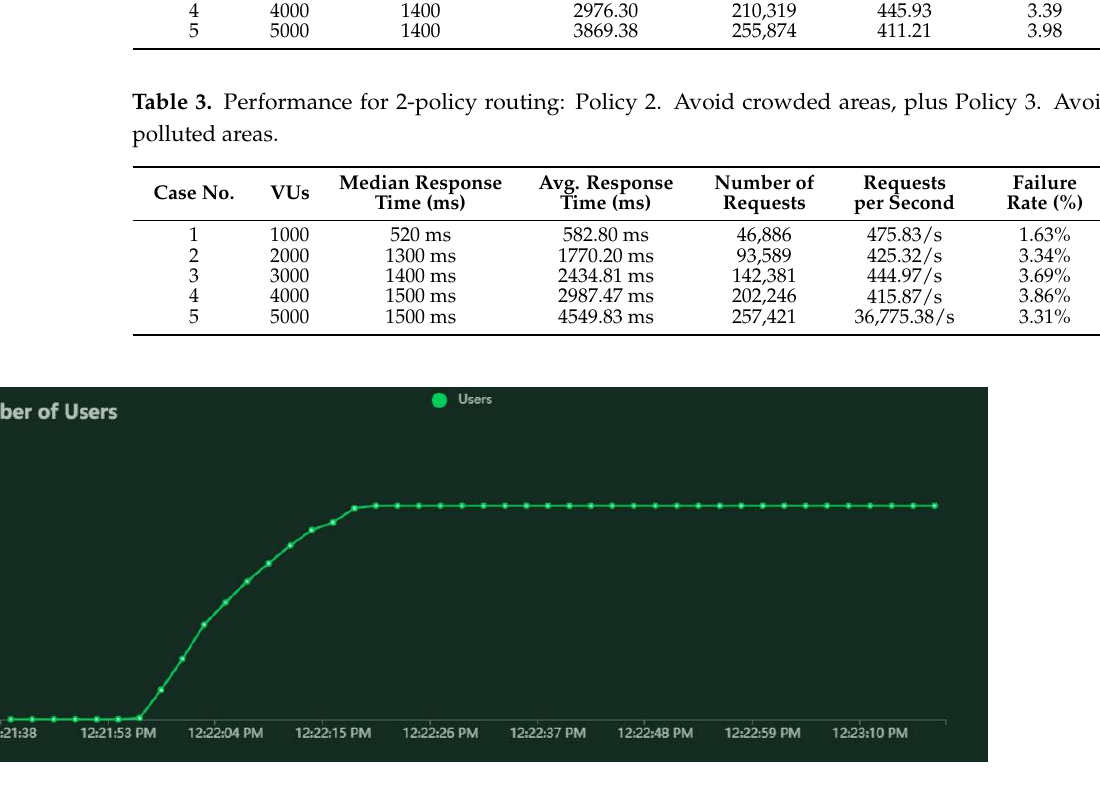
Figure 4. Results for 1000 VU spawn in the system and held 60 s.